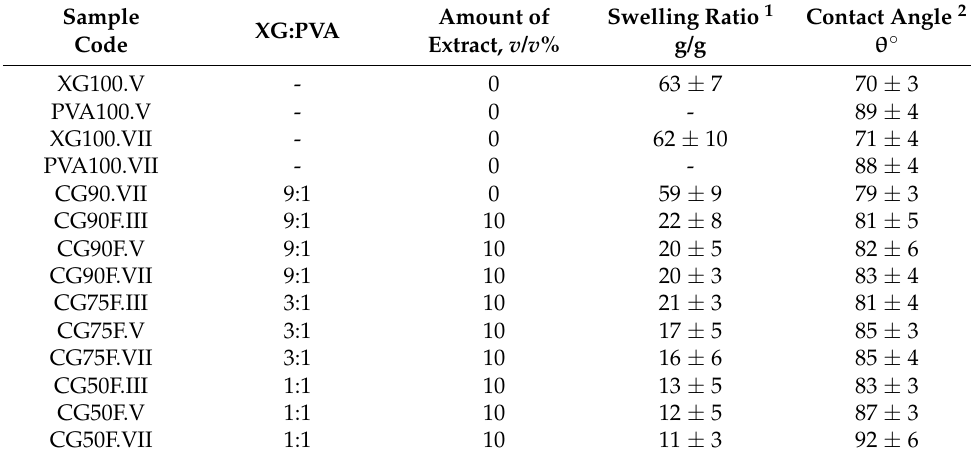
Table 1. Sample codes, composition, and some characteristics of composite